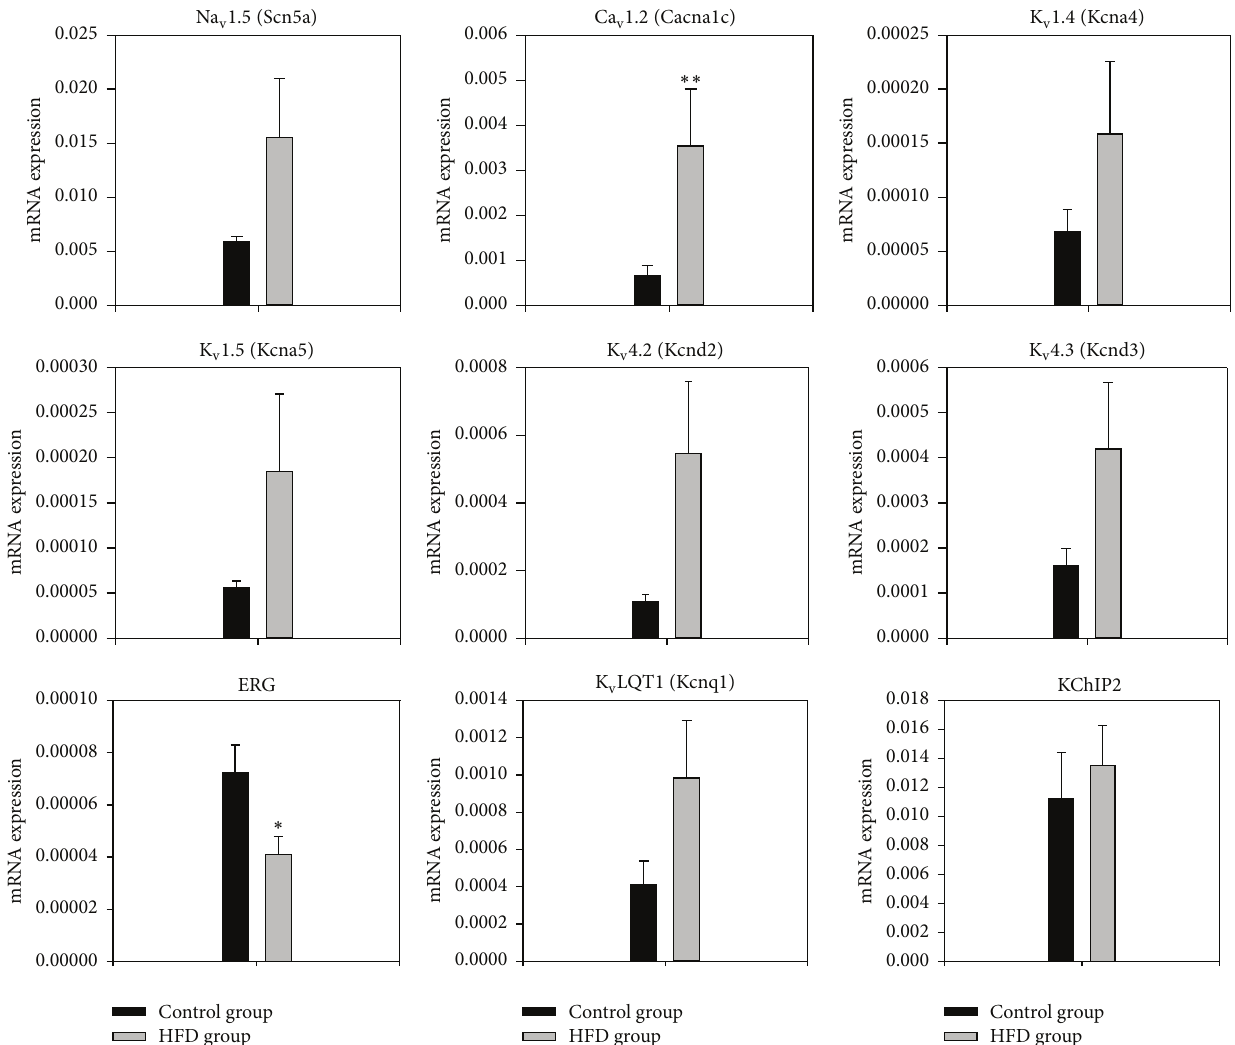
Figure 1: Normalised to 18-s expression of mRNA for major ion channels active during the action potential in the left ventricle of the control and obesity groups in arbitrary units referenced to the housekeeper gene 18-s. Means ± SEM shown ( 𝑛 = 8 /group). ∗ Significantly different from the control group ( 𝑃 < 0.05 ). ∗∗ Significantly different from the control group ( 𝑃 < 0.01